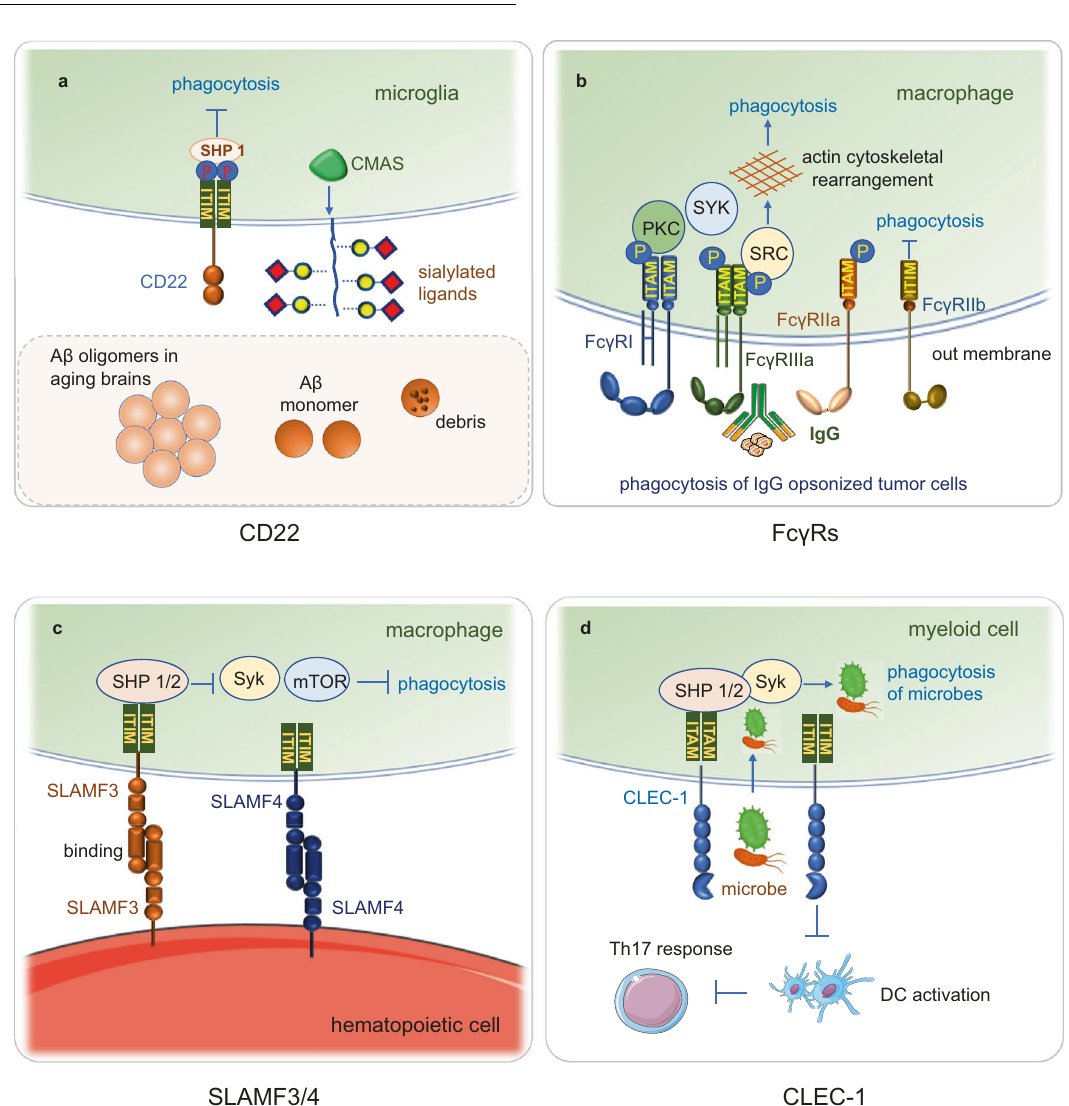
Fig. 3 The phagocytosis receptors CD22, Fc receptors, SLAMF3/4 and CLEC1. a CD22 binds α 2,6-linked sialic acid and recruits tyrosine phosphatase SHP-1 to inhibit the phagocytic capacity of microglia. The anti-CD22 treatment enhanced clearance of injected oligomeric amyloid- β (A β ), myelin debris and α -synuclein fi brils in aging brains. CMAS is a key synthase functioning in sialic acid synthesis, related to CD22 function. b Fc γ RIIb, Fc γ RI, Fc γ RIIIa, and Fc γ RIIa are expressed on macrophages. Fc γ Rs crosslink IgG immune complex triggers phosphorylation of their ITAMs and activates kinases of SYK, SRC and PKC pathway, kinase activation leads to actin remodeling, which is crucial for phagocytosis of the IgG immune complex. Fc γ RIIB is the only phagocytosis-inhibitory receptor, and the other family members are phagocytosis-activating receptors within the human Fc γ R family. Fc γ RIIB contains an ITIM in its cytoplasmic region, and the phosphorylation and activation of the ITIM recruit the phosphatases SHP1 and SHP2 and inhibit downstream phagocytosis. c SLFRs are ubiquitously expressed in hematopoietic cells. SLAMF3 and SLAMF4 were identi fi ed as “ don ’ t eat me ” receptors on macrophages. They inhibit “ eat me ” signals, such as lipoprotein receptor-related protein 1 (LRP1) -mediated activation of mTOR and Syk to macrophages through SH2 domain-containing phosphatases and hematopoietic cells without SFRs are easily phagocyted by macrophages. d CLEC-1 is expressed primarily by myeloid cells, CLEC-1 on human DC dampens DC activation and restrains downstream Th17 responses, CLEC-1 is a novel myeloid immune checkpoint limiting tumor cells ’ phagocytosis and tumor antigen presentation. CLRs binding to microbial surfaces in fl uence phagocytosis by promoting in fl ammatory signals and triggering intracellular signaling to induce phagocytosis of microbes Fc receptors . Fc receptors (FcRs) are cell-surface receptors comprises an ITIM in its cytoplasmic region, 156 and the present on several hematopoietic cells that speci fi cally recognize phosphorylation and activation of the ITIM recruit the phospha- the Fc region of immunoglobulin (Ig) to regulate phagocytosis and tases SHP1 and SHP2 and inhibit phagocytosis in their down- antibody-dependent cell-mediated cytotoxicity (ADCC). 154 Gener- stream (Fig.3b). ally, type I Fc common gamma receptors (Fc γ Rs) are divided into FcRs are present on different immune cells, such as monocytes, activating or inhibitory subtypes. The activating Fc γ Rs include macrophages, DCs, and neutrophils, and the unique expression Fc γ RI, Fc γ RIIa, Fc γ RIIc and Fc γ RIIIa, all of which contain immunor- patterns of individuals or combinations of Fc γ Rs balance cellular eceptor tyrosine activating motifs (ITAMs); Fc γ RIIB is the only immune responses. 156 Fc γ RIIb, Fc γ RI, Fc γ RIIIa, and Fc γ RIIa are phagocytosis-inhibitory receptor, and the others are phagocytosis- expressed on macrophages. IgG immune complexes activate Fc γ R activating receptors within the human Fc γ R family. 155 Fc γ RIIB signaling for different subtypes of IgG, with complex binding Signal Transduction and Targeted Therapy (2023)